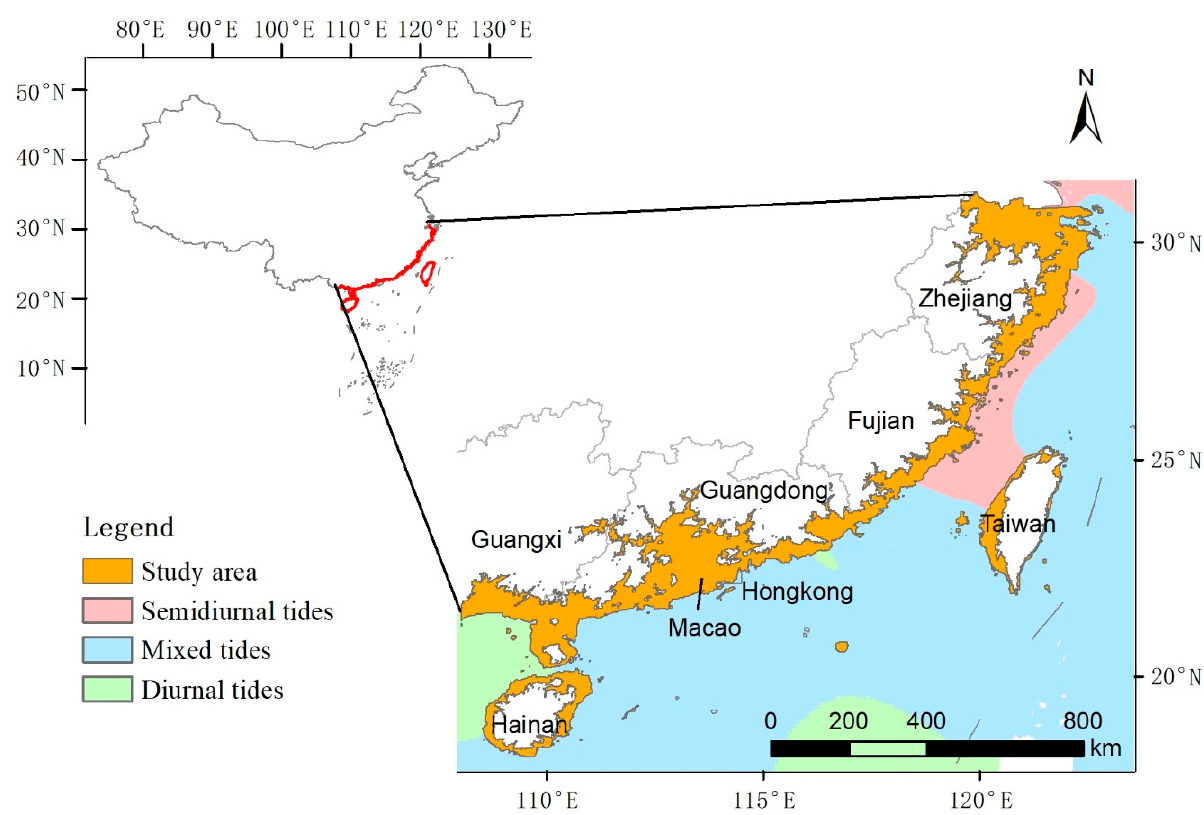
Figure 1. Map of the study area (adapted from Zhao and Qin [18]). The area covers about half of China’s coastline, including the coastal areas of Zhejiang, Fujian, Guangdong, Guangxi Zhuang Autonomous, Hong Kong, Macao, Taiwan, and Hainan.